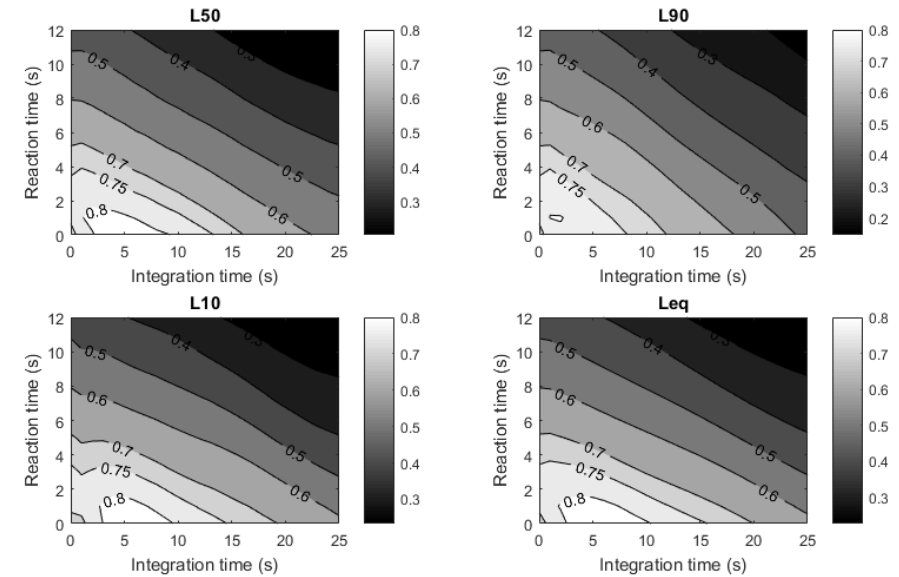
Figure 6. Pearson correlation coefficient between pleasantness and L 50 , L 90 , L 10 , and L eq , with varying reaction and integration times.